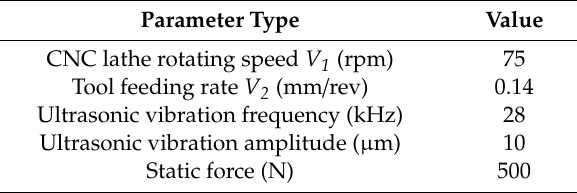
Figure 1. Schematic of the ultrasonic surface rolling process. Table 2. Processing parameters utilized in ultrasonic surface rolling process